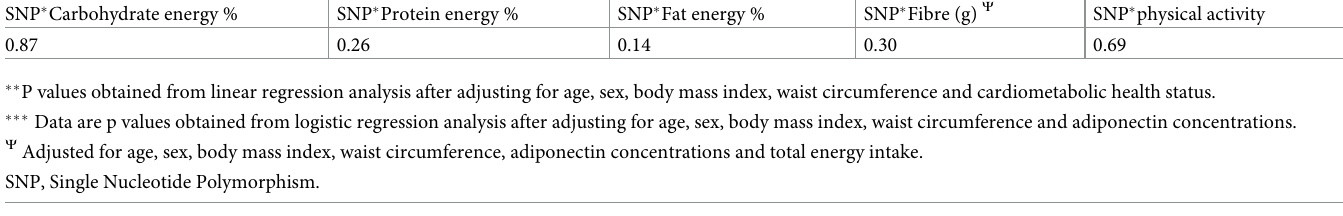
Table 2. Interactions between the Omentin SNP rs2274907 and lifestyle factors on adiponectin concentrations and cardiometabolic health status. P values for the interactions between the Omentin SNP and dietary factors on serum adiponectin concentrations �� SNP � Carbohydrate energy % P values for the interactions between the Omentin SNP and dietary factors on cardiometabolic health status ��� SNP � Carbohydrate energy %